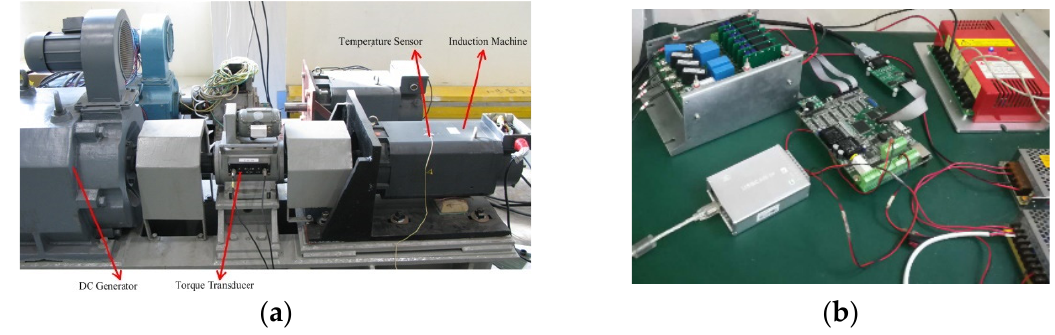
Figure 11. Experiment setup. ( a ) is the induction machine and load. and ( b ) is the control and power board.